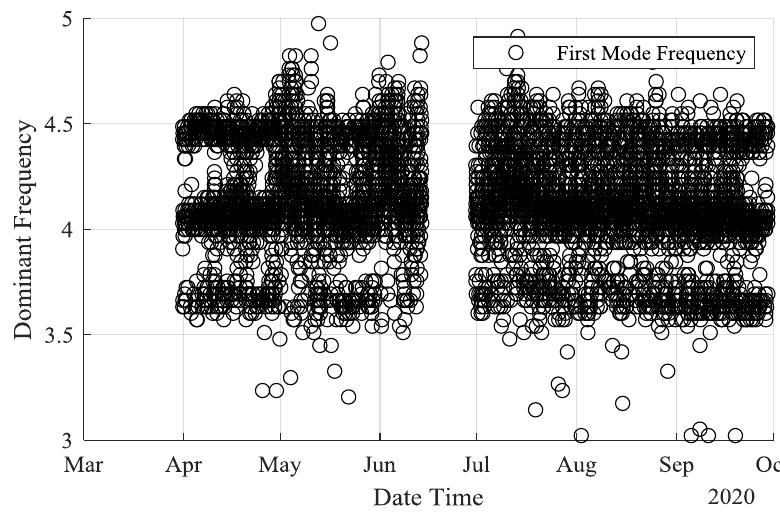
Figure 26. ( a ) Sensor positions and bridge dimension; ( b ) power supply for accelerometer and NB- IoT; ( c ) side view of Wenzhou bridge.